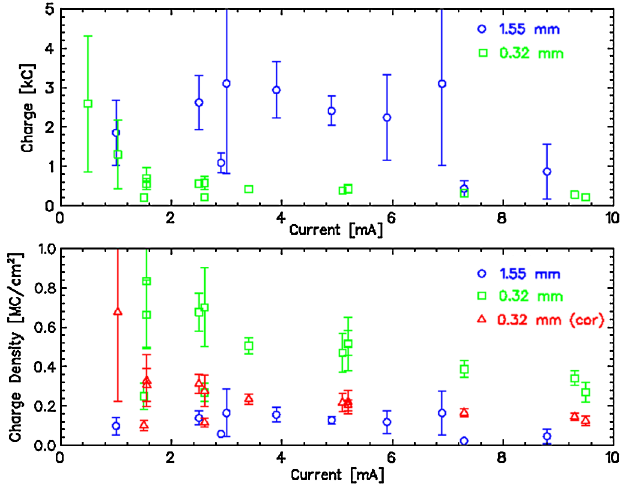
FIG. 9. (Top) Measured charge lifetime vs average beam current for small and large laser spots, and (bottom) fluence lifetime vs average beam current for the two laser spot sizes. Red data points correspond to measurements corrected for radial dependence, see text.